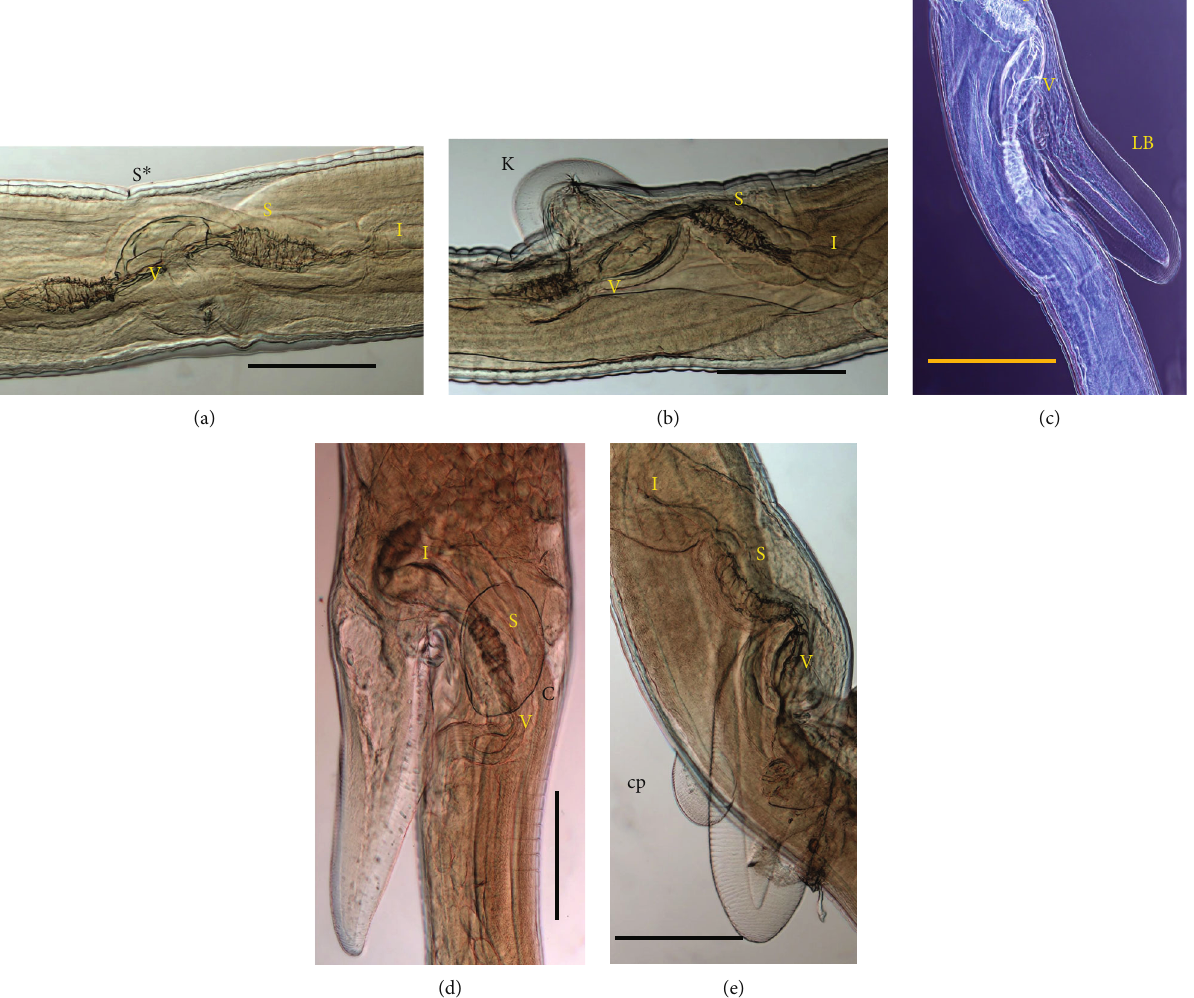
Figure 2: (a) Smooth (S*). (b) Knobbed (K). (c) Linguiform B (LB); (d) Linguiform A with one cuticular in fl ation (C; scale bar 50 μ m). (e) Linguiform C with cuticular raised from the linguiform process (cp). I: anterior infundibulum; S: anterior sphincter; V: vestibular (scale bar 200 μ